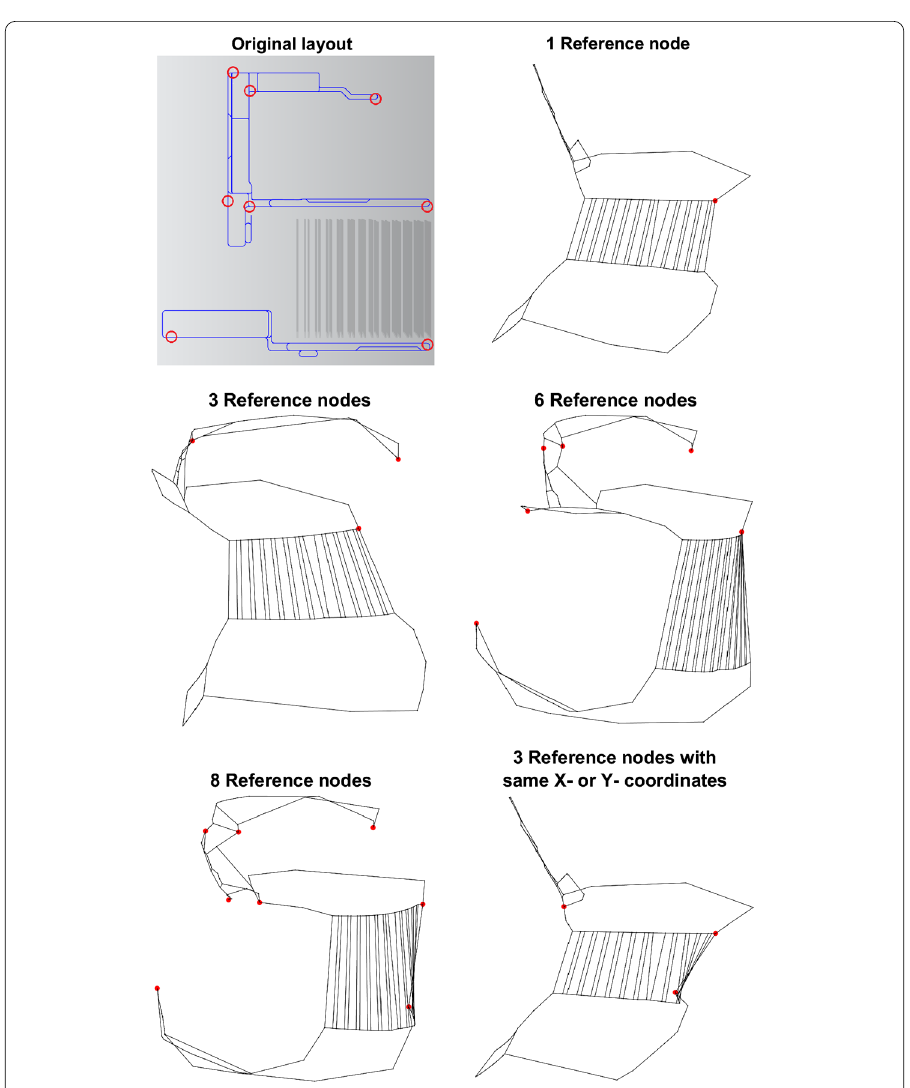
Figure 21 Comparison of initial layouts with different numbers of reference nodes